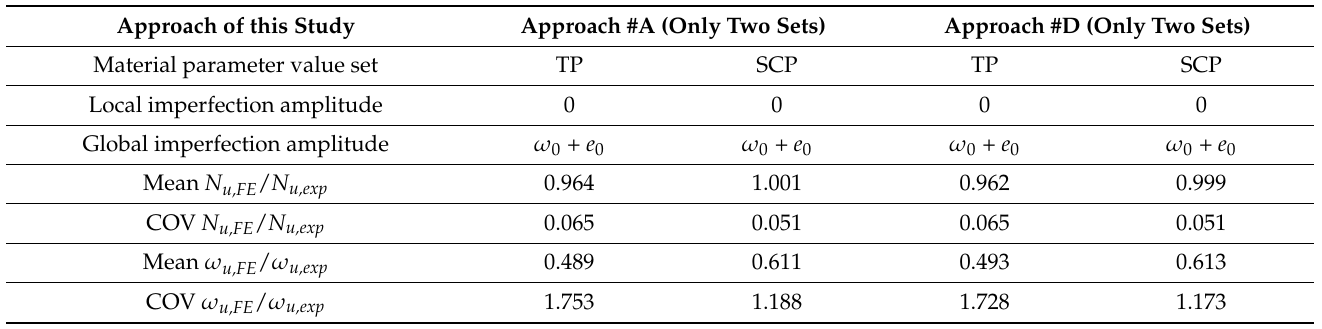
Table 15. Comparison of approaches #A and #D. Summary of the average N u,FE / N u,exp and ω u,FE / ω u,exp values for varying material properties, based on the results of the cross-section sets 106 × 3 and 104 × 2 (Tables 8, 9, 13 and 14). Approach of this